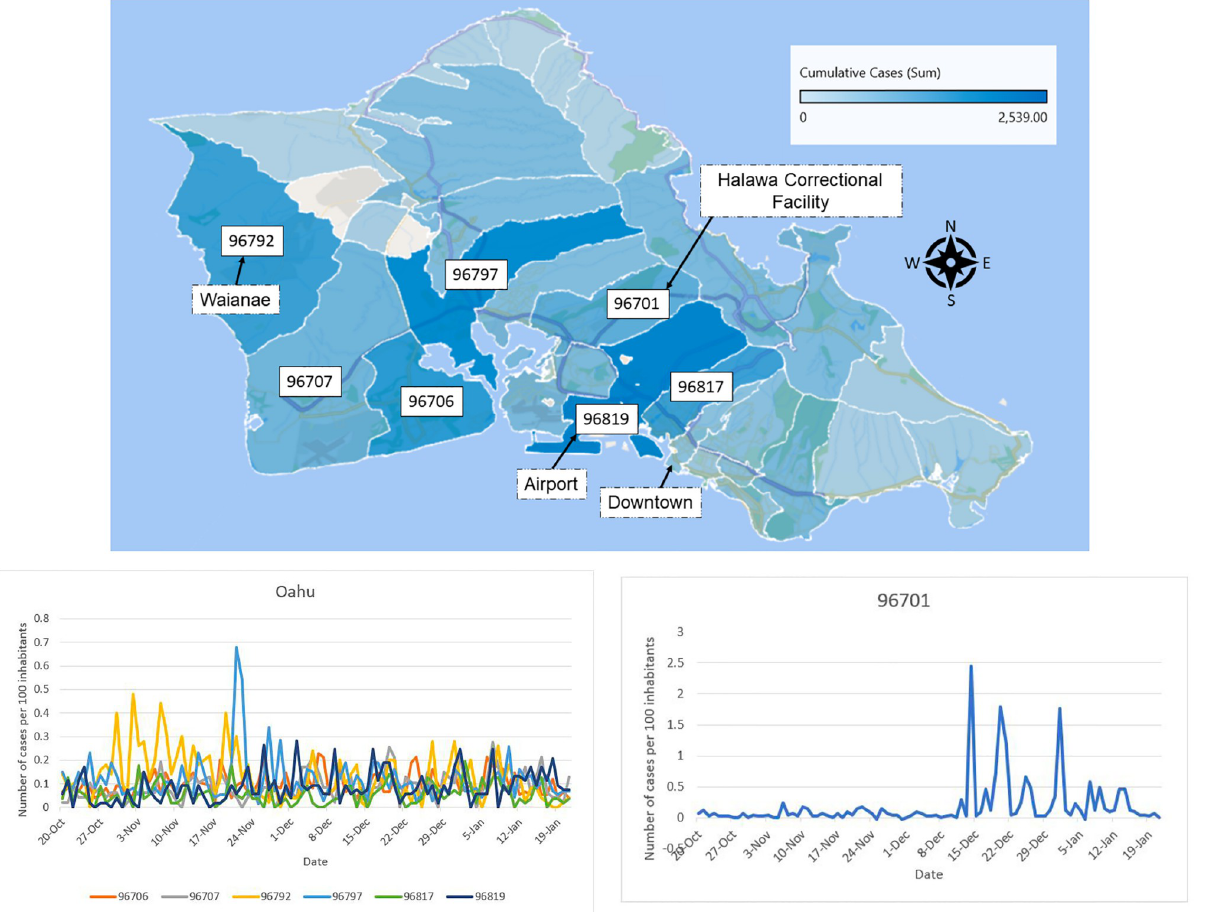
Fig 8. Honolulu county cumulative daily counts distributed per zip code from March 2020 to January 18, 2021. A: Map produced using Excel Map charts). B: Honolulu county cumulative daily counts distributed per zip code.